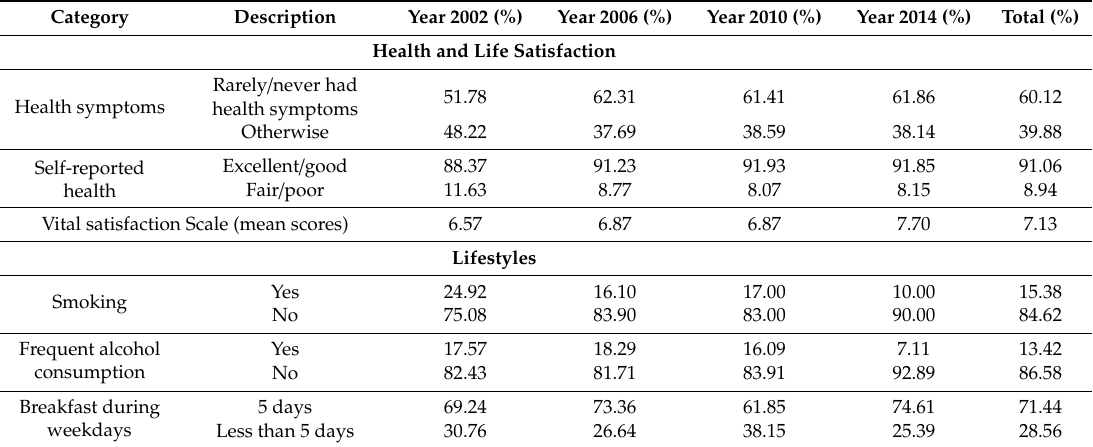
Table 3. Descriptive analysis of the dependent